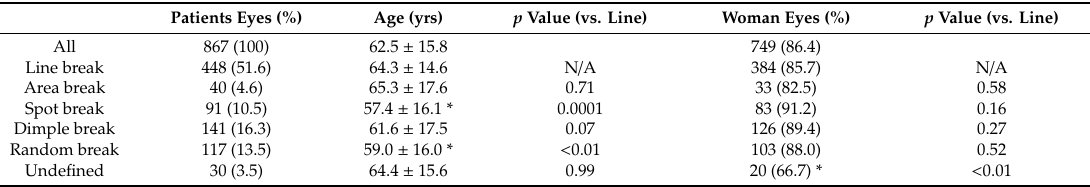
Table 1. Characteristics of FBUPs of the study population. Among 867 eyes included in the final analysis, approximately half (51.6%) were classified as line